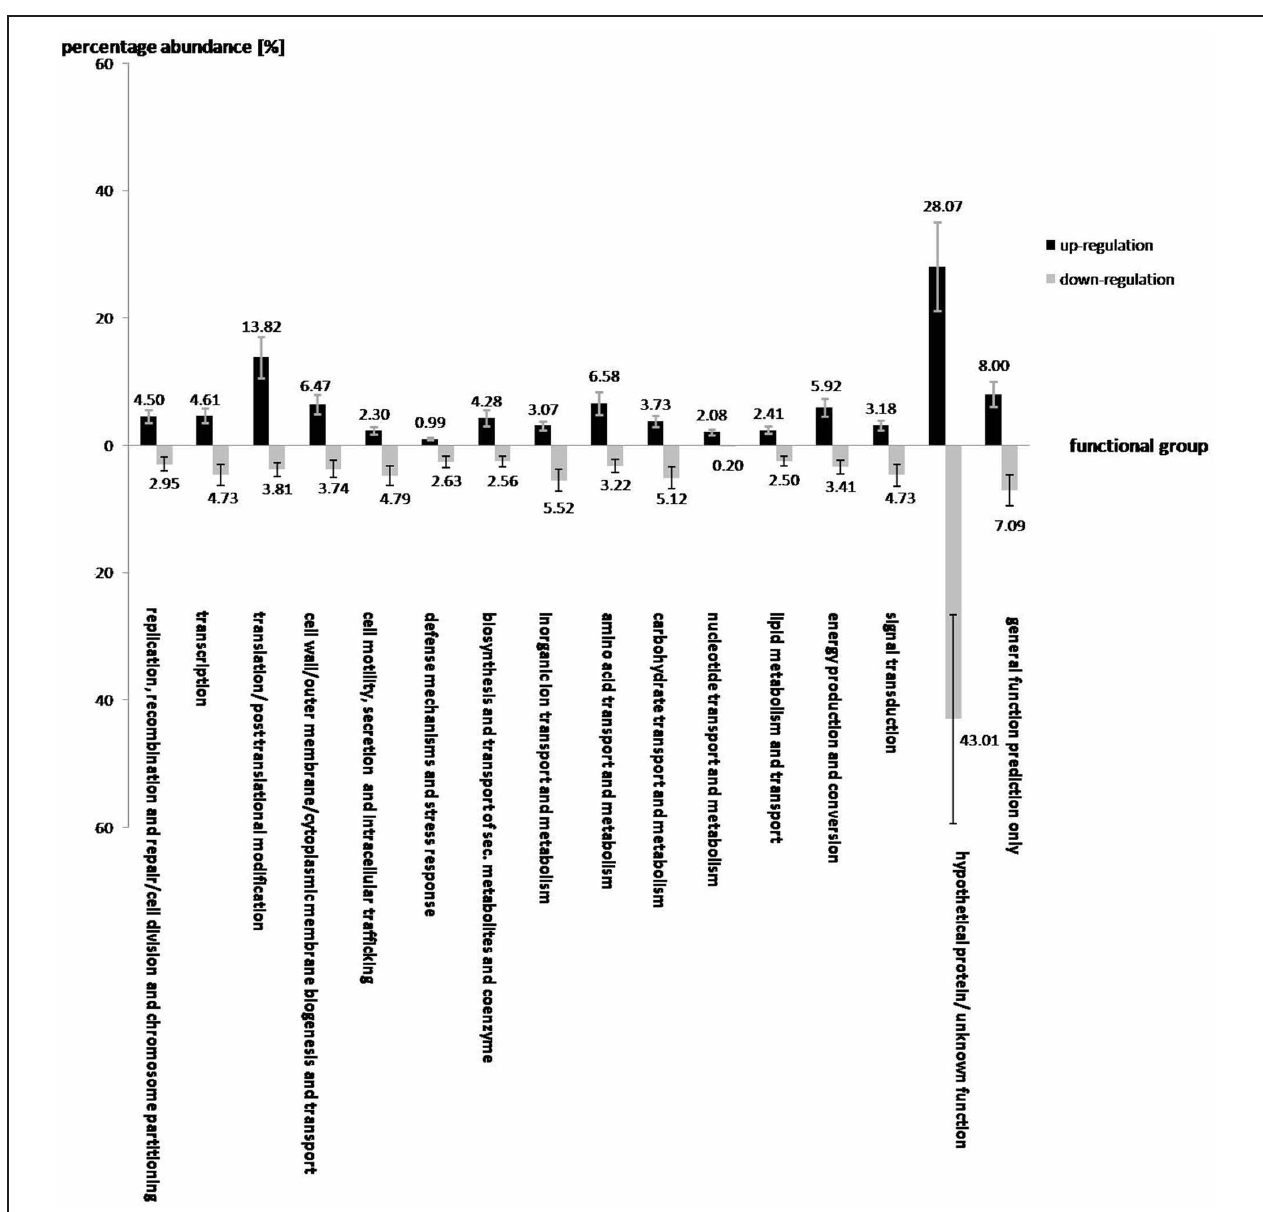
FIGURE 1 | The effect of salt shock on the gene expression of various functional gene groups in S. rhizophila DSM14405 T . A total of 912 and 1521 genes were significantly up and down-regulated, respectively. The impact of salt stress on most functional gene groups is clearly pronounced, as a given functional group shows either an increase or decrease in the transcription of genes belonging to that group. Genes involved in translation, synthesis of the cell wall, outer or cytoplasm membrane, nucleotide and amino acid transport and metabolism, energy production and conversion are up-regulated. In contrast, genes involved in cell motility, secretion, and intracellular trafficking, defense mechanisms, and transport and metabolism